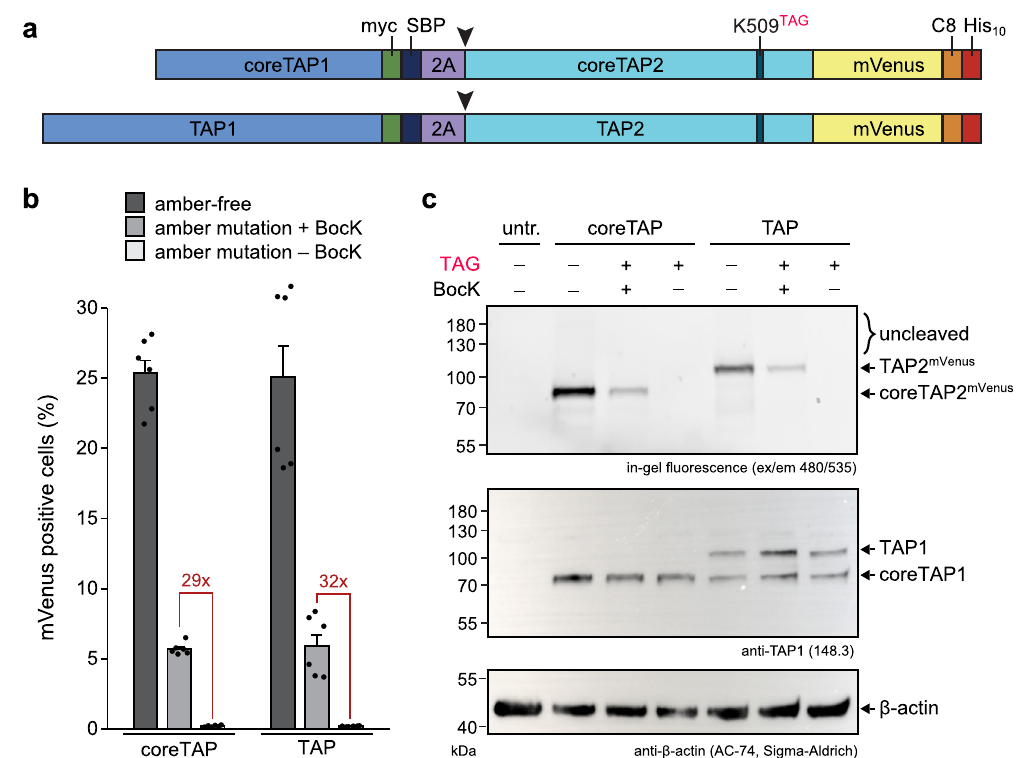
Fig. 2 Design of amber-suppressed TAP constructs. a Schematic representation of the TAP variants with amber mutation in TAP2 (K509, GPNGSG K ST). Separation into single TAP1 and TAP2 subunits encoded by an F2A site (purple) is highlighted by a black arrow. SBP streptavidin-binding peptide. b Co- expression of amber-free or amber-suppressed coreTAP or TAP with wtPylRS in the presence or absence of 250 µ M BocK in TAP2-de fi cient STF1-169 cells analyzed by fl ow cytometry (mean ± SEM, n = 6, biologically independent samples). c F2A separation and amber-suppression ef fi ciency for co-expression of coreTAP or TAP with wtPylRS in TAP2-de fi cient STF1-169 cells analyzed by SDS-PAGE, in-gel fl uorescence (mVenus), and immunoblot (anti-TAP1 and β -actin). Constructs with amber mutation (TAG) were expressed with or without 250 µ M BocK (representative data, n = 2, biologically independent samples). untr. untransfected